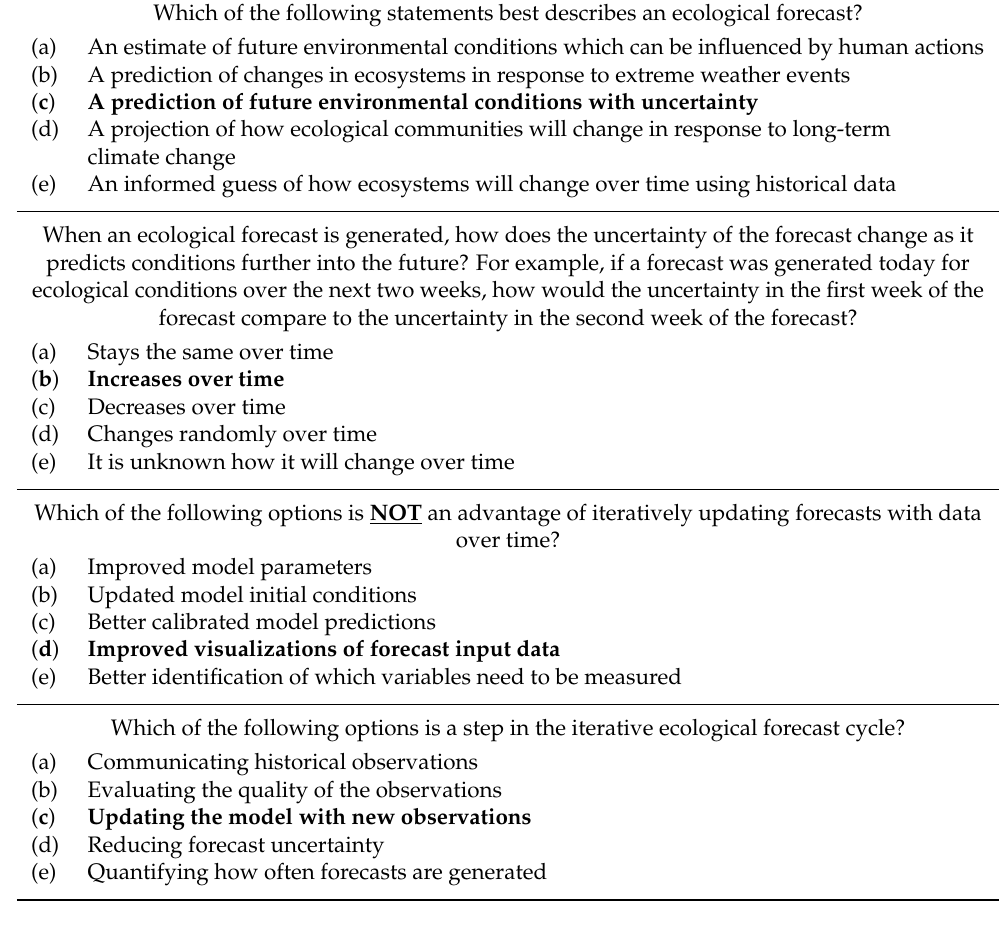
Table A2. Quantitative assessment questions for pre- and post-module responses for the module. The correct answers are